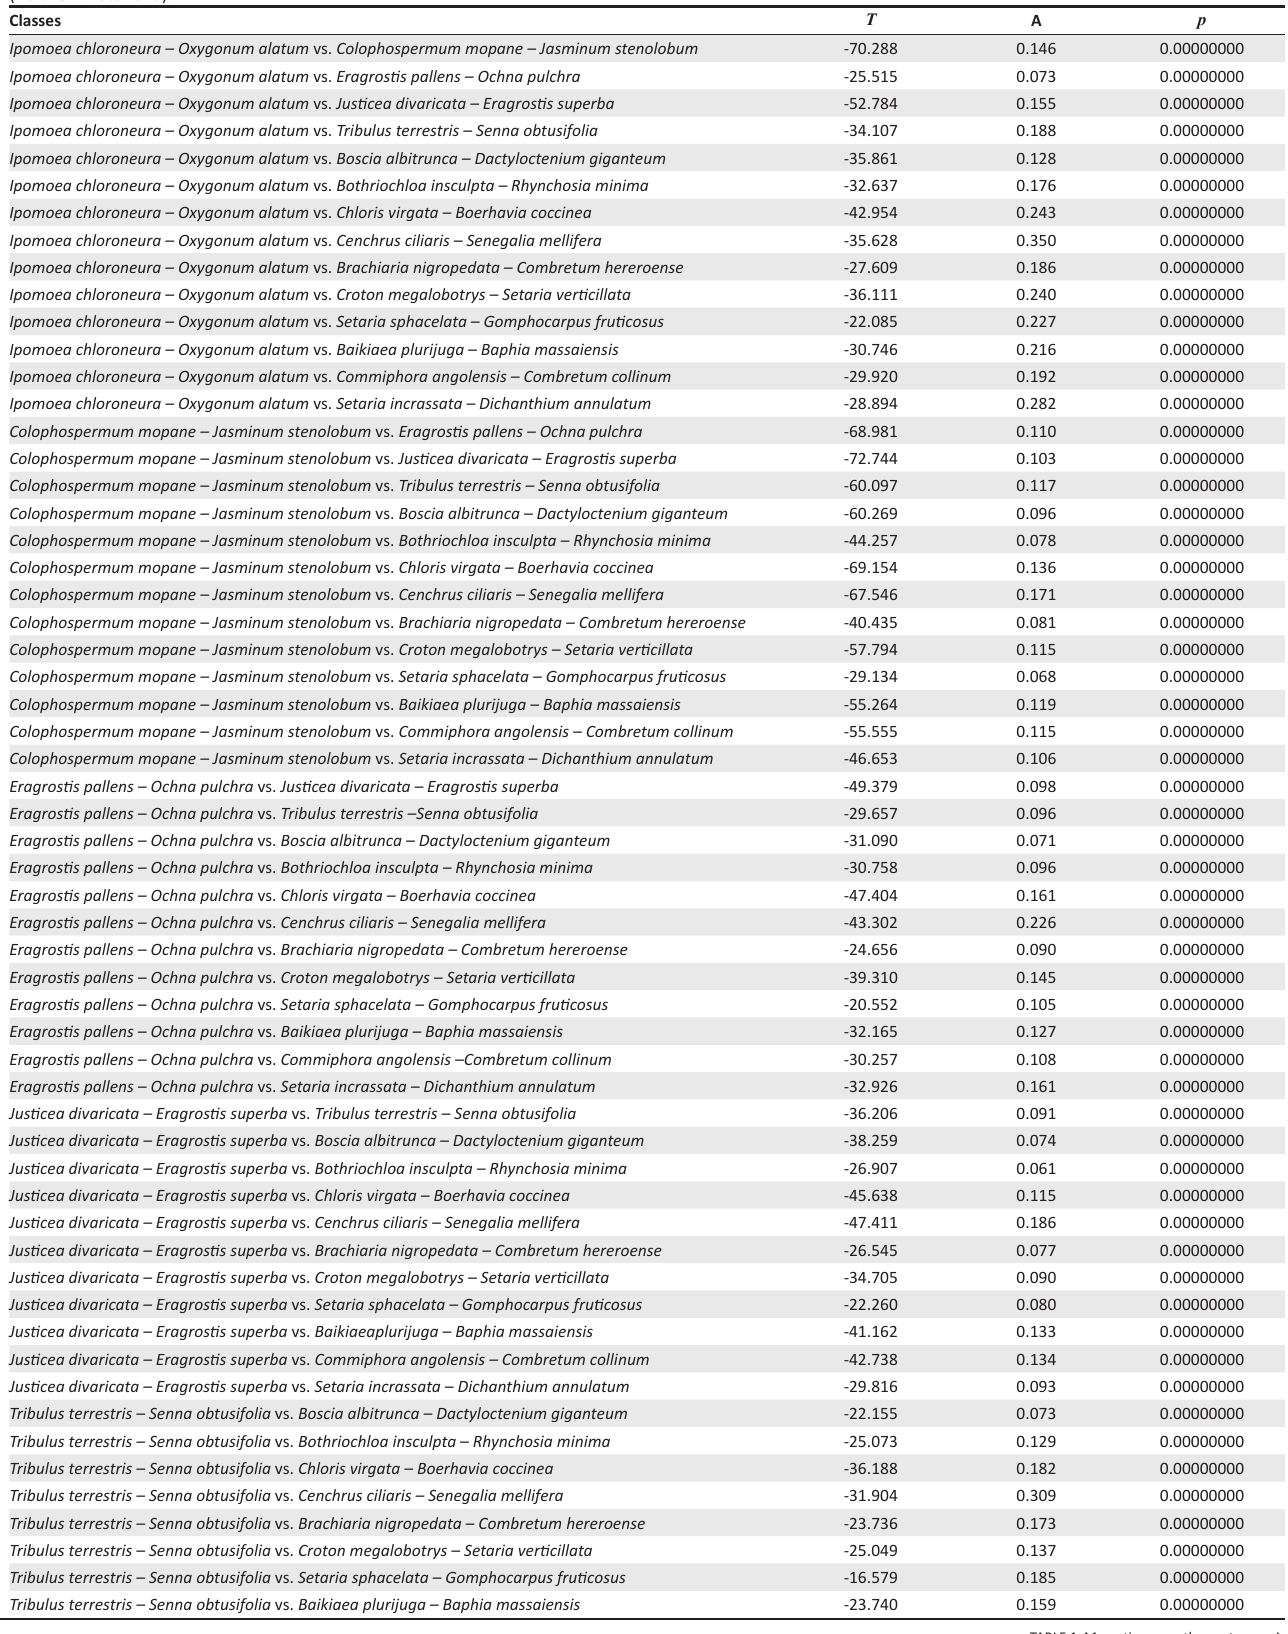
TABLE 1-A1: Multiresponse permutation procedure pairwise comparisons between identified classes for plant communities in the Savuti-Mababe-Linyanti ecosystem (northern